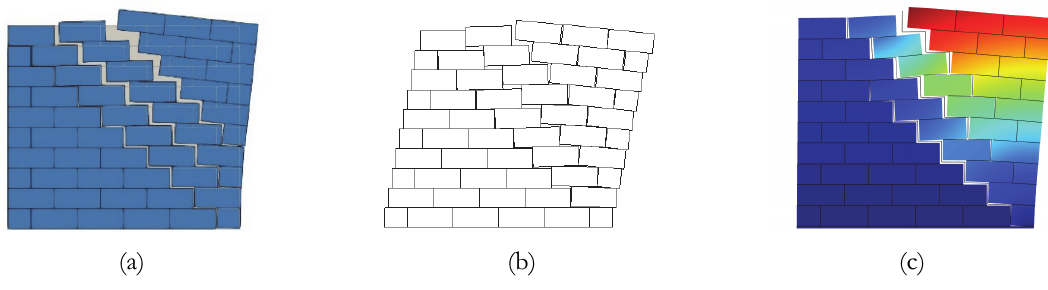
Figure 5: Collapse mechanism for Example 2, horizontal live load: ( a ) ALMA 2.0, ( 𝑏 ) FEM/DEM, ( 𝑐 ) FEM